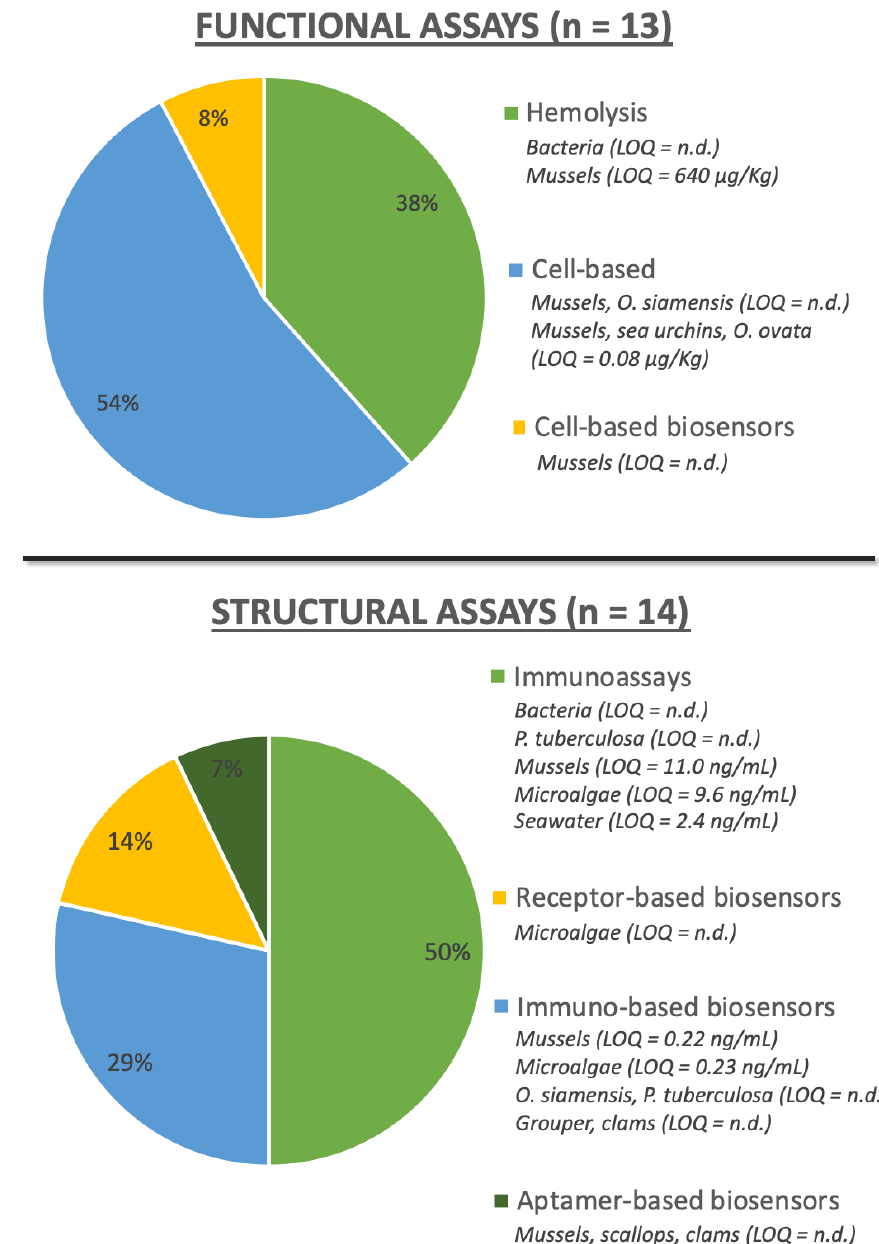
Figure 3. Overview of the functional and structural assays for PLTX detection.